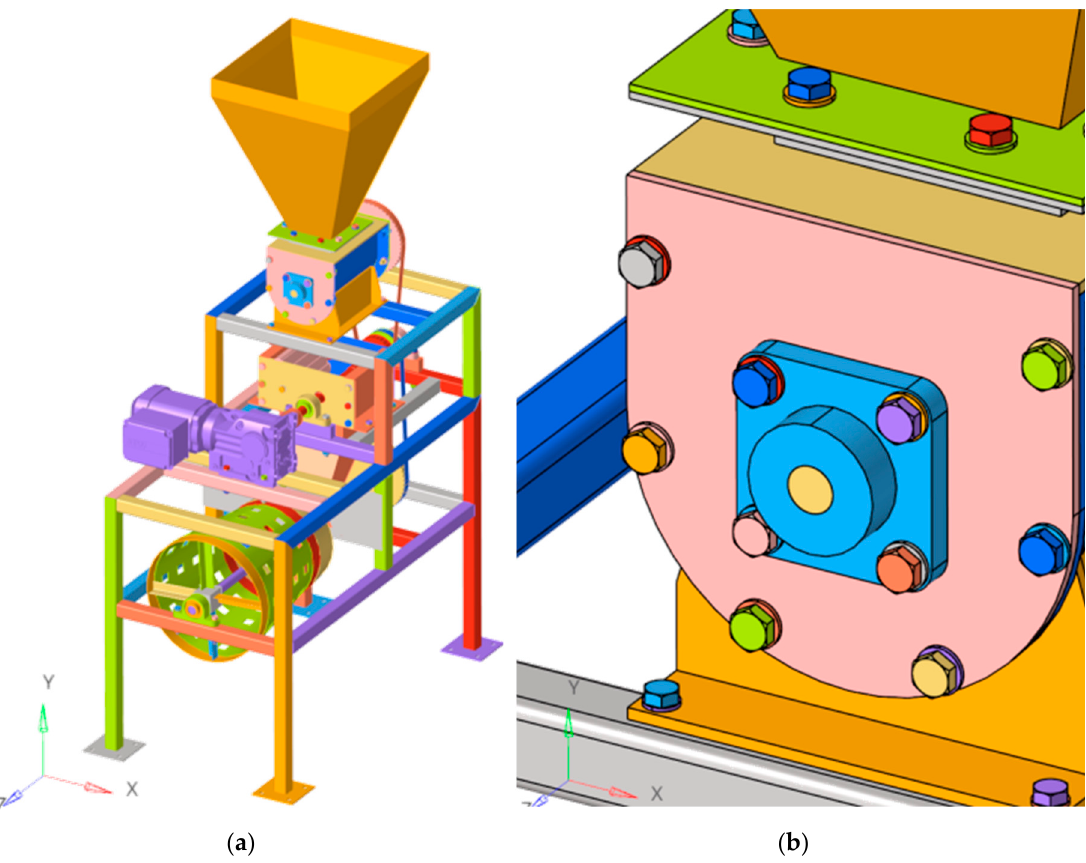
Figure 15. ( a ) Three-dimensional (3D) model considered in computer-aided engineering (CAE) analysis; ( b ) bearing support detail.